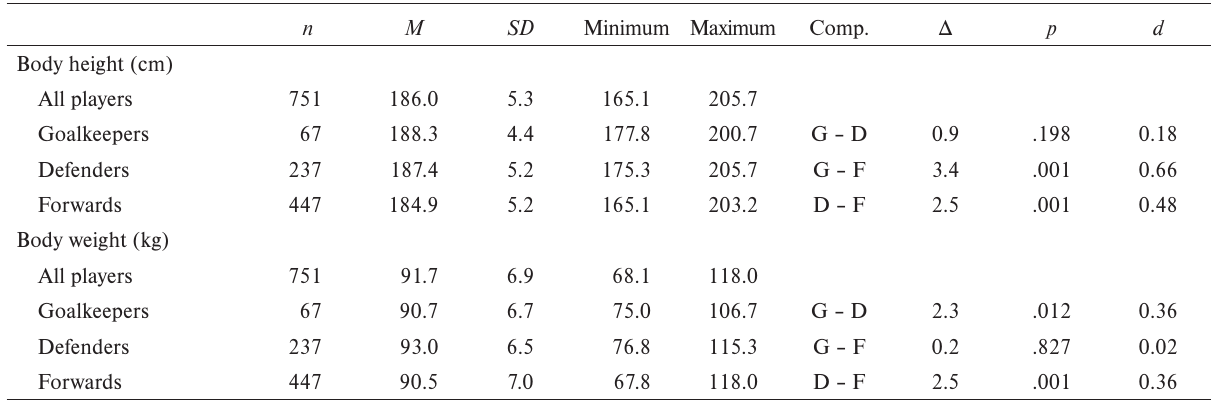
Body height and body weight and statistical comparison of differences and effect size of current ice hockey players of NHL – goalkeepers (G), defenders (D), forwards (F)